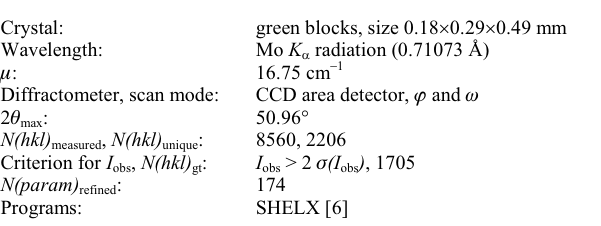
Table 1. Data collection and handling.